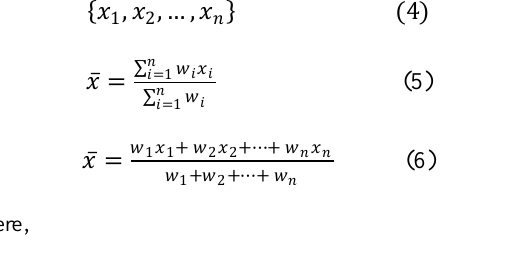
Figure 5. Example of building footprints classified into different